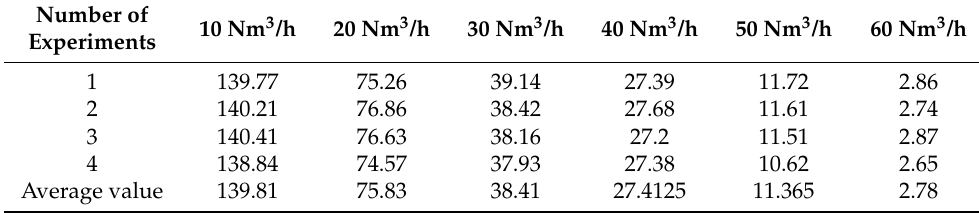
Table 10. Liquid content in Case 2 at M 2 (g/m 3